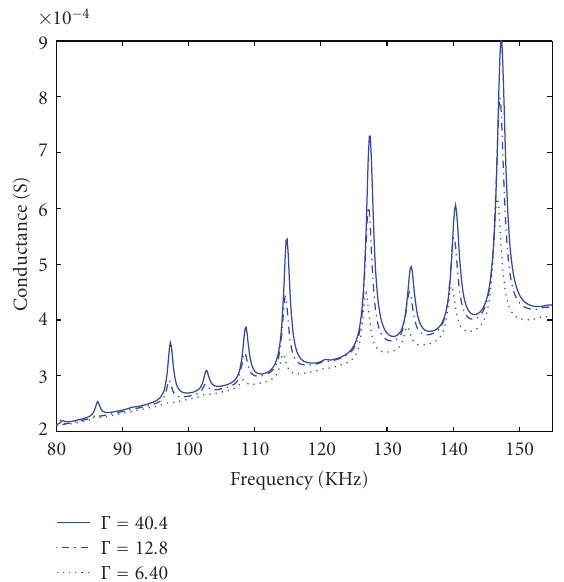
Figure 8: EM admittance signatures for various interfacial condi-